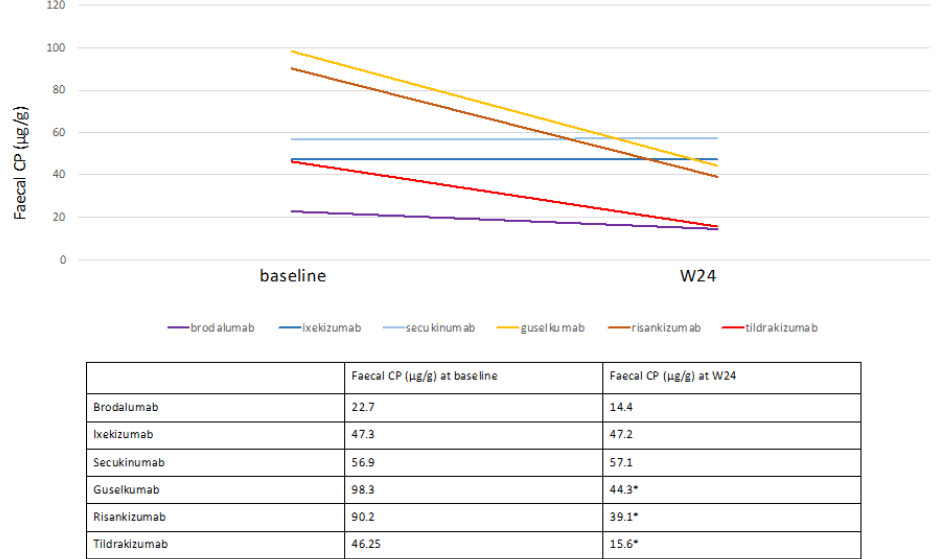
Figure 3. Mean baseline and W24 faecal CP levels stratified by single biological drug. Data are displayed as mean. Statistical analysis was performed with Wilcoxon matched pairs test, * p < 0.05.